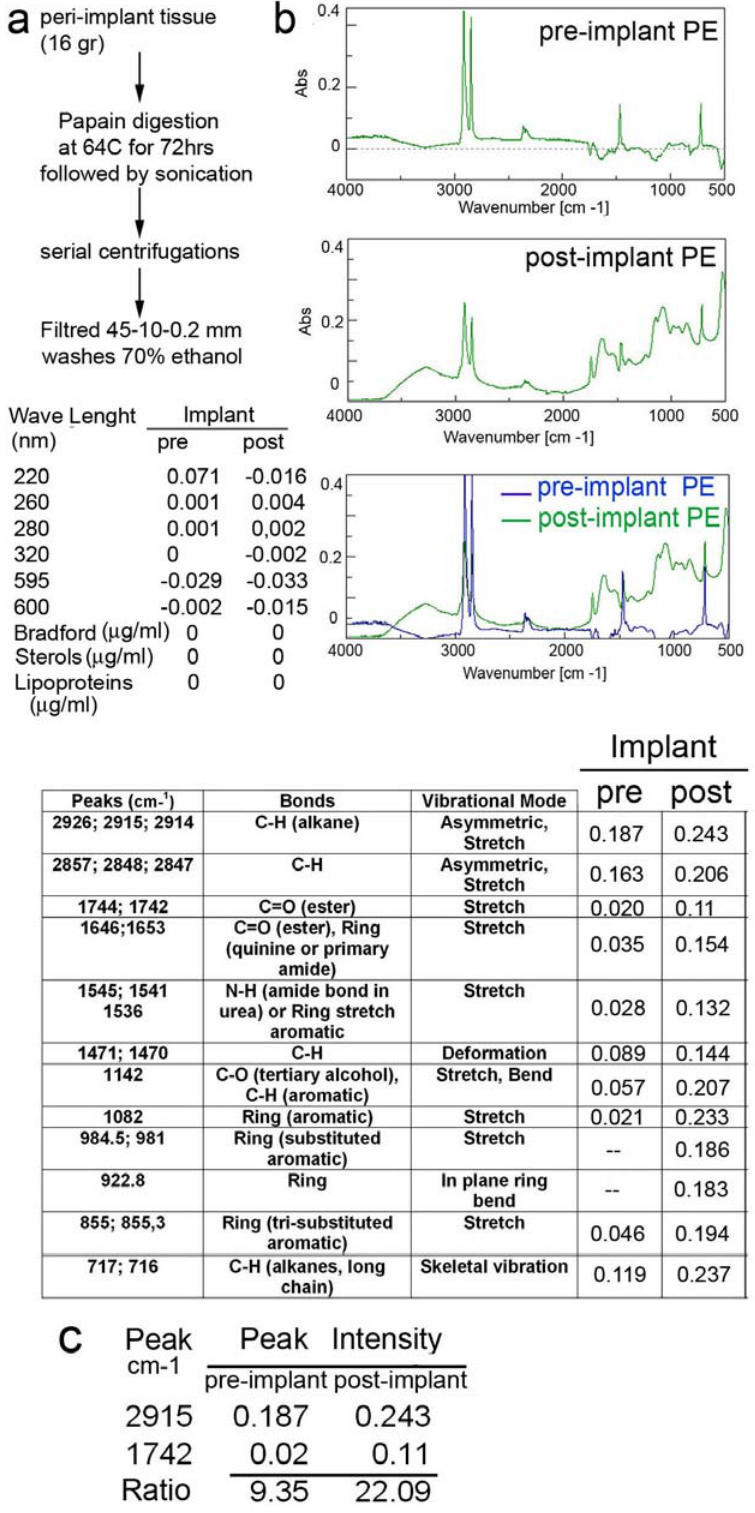
Figure 2. Modified alkane polymers purified from periprosthetic material increase their number of carbonyl groups. a) Purification scheme of post implant PE. Optical density of the preparation was measured at different relevant wavelengths at a PE concentration of 100 m g/ml. Bradford, lipid and sterol assays were also performed using100 ug/ml post-implant PE material. b) Fourier transformed infra-red spectroscopic (FTIR) analysis pre-implant (new polyethylene implant) and post-implant PE (polyethylene material purified from the site of osteolysis). The analysis was carried out between 4000 and 500 cm 2 1 wave number. b) Tabular representation of the prominent peaks (cm 2 1 ), and the predicted bonds with the relevant vibrational modes for pre-implant and post-implant PE. Integral intensities are given for each prominent peak. c) Total integral intensity of alkane and carbonyl groups in pre and post-implant material. Ratio between the two groups is shown.